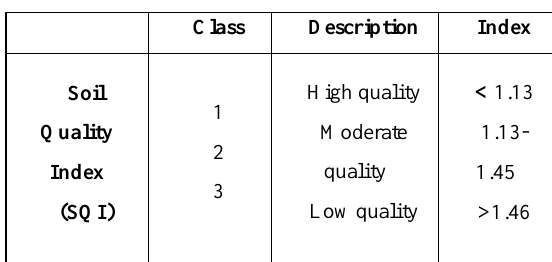
Table1. Soil quality index description